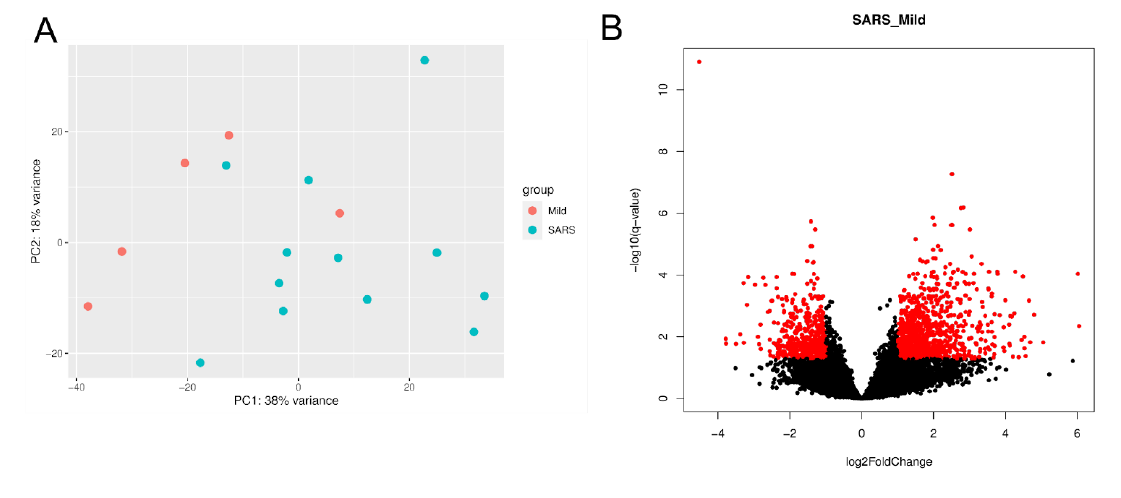
Figure 1. Differential expression gene analysis. The principal component analysis ( A ) shows that the RNA-seq libraries from the mild and SARS patients were grouped distinctly, except for one individual in each group. Volcano plot ( B ) displaying (with red dots) the differentially expressed genes (log 2 fold-change > |1| and adjusted p -value < 0.05).